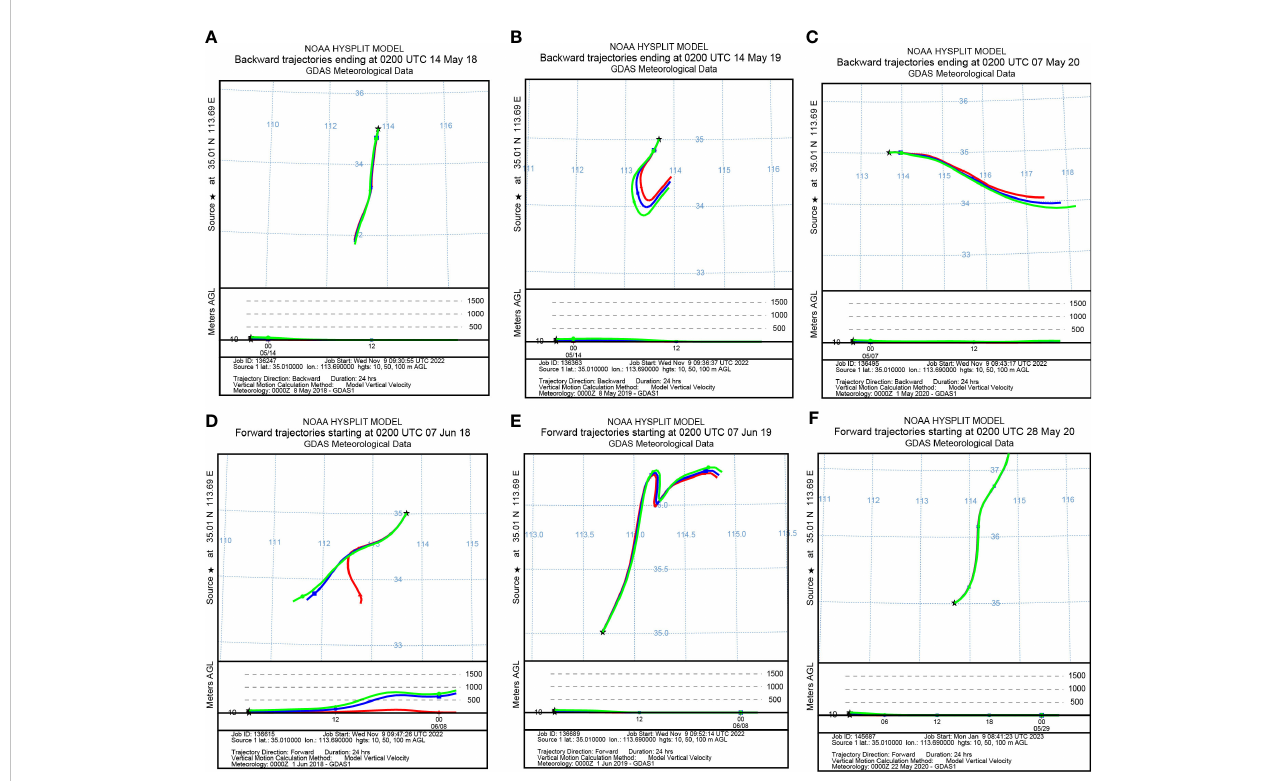
FIGURE 4 The migration trajectories of Rhopalosiphum padi simulated by HYSPLIT. (A, B) Simulation of the backward trajectories on 14 May 2018 and 14 May 2019, respectively. (C) Simulation of the backward trajectories on 7 May 2020. (D, E) Simulation of the forward trajectories on 7 June 2018 and 7 June 2019, respectively. (F) Simulation of the forward trajectories on 28 May 2020.